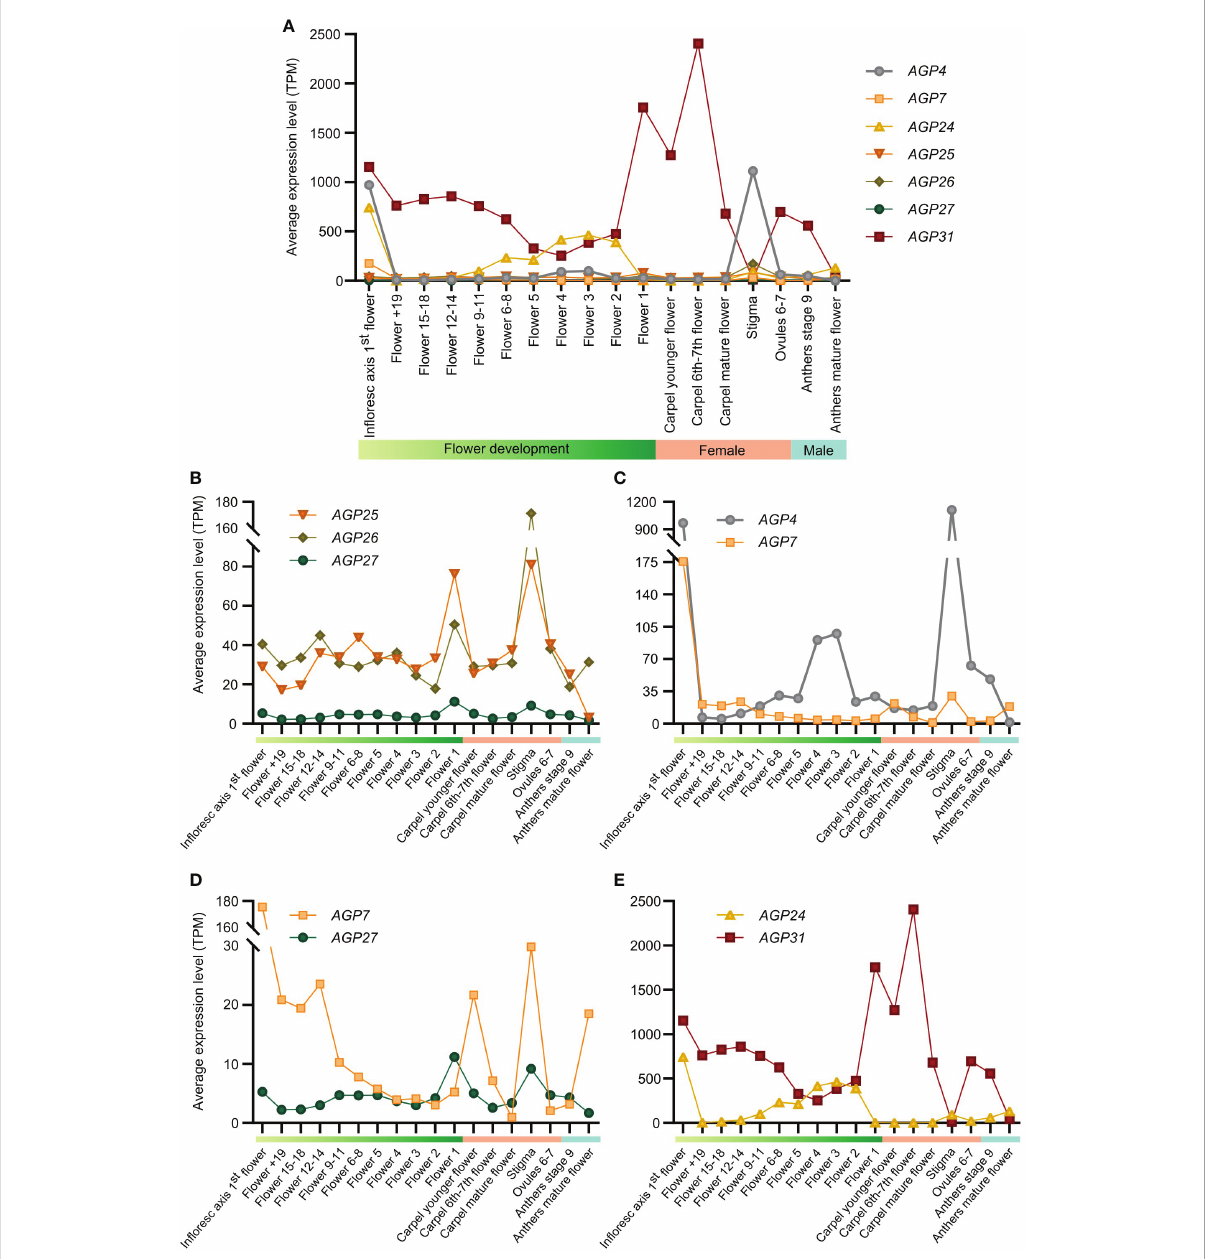
FIGURE 1 Expression pattern analysis of AGP4, AGP7, AGP24, AGP25, AGP26, AGP27 and AGP31 based on RNA-Seq data. Expression levels are presented in transcript per million (TPM) obtained from the RNAseq data published by Keplikova et al. (2016). We show the expression level for the samples most related to the reproductive process [stages according to Klepikova et al. (2016)]. (A) Expression pattern analysis based on RNA-seq data for seven AGPs ( AGP4 , AGP7 , AGP25 , AGP26 , AGP27 and AGP31 ) in samples related to reproductive processes. (B) Expression pattern analysis based on RNA- seq data for three phylogenetically close AGPs (AGP25, AGP26 and AGP27) in samples related to reproductive processes. (C) Expression pattern analysis based on RNA-seq data for two phylogenetically close AGPs ( AGP4 and AGP7 ) in samples related to reproductive processes. (D) Expression pattern analysis based on RNA-seq data for AGP7 and AGP27 in samples related to reproductive processes. (E) Expression pattern analysis based on RNA-seq data for AGP24 and AGP31 in samples related to reproductive